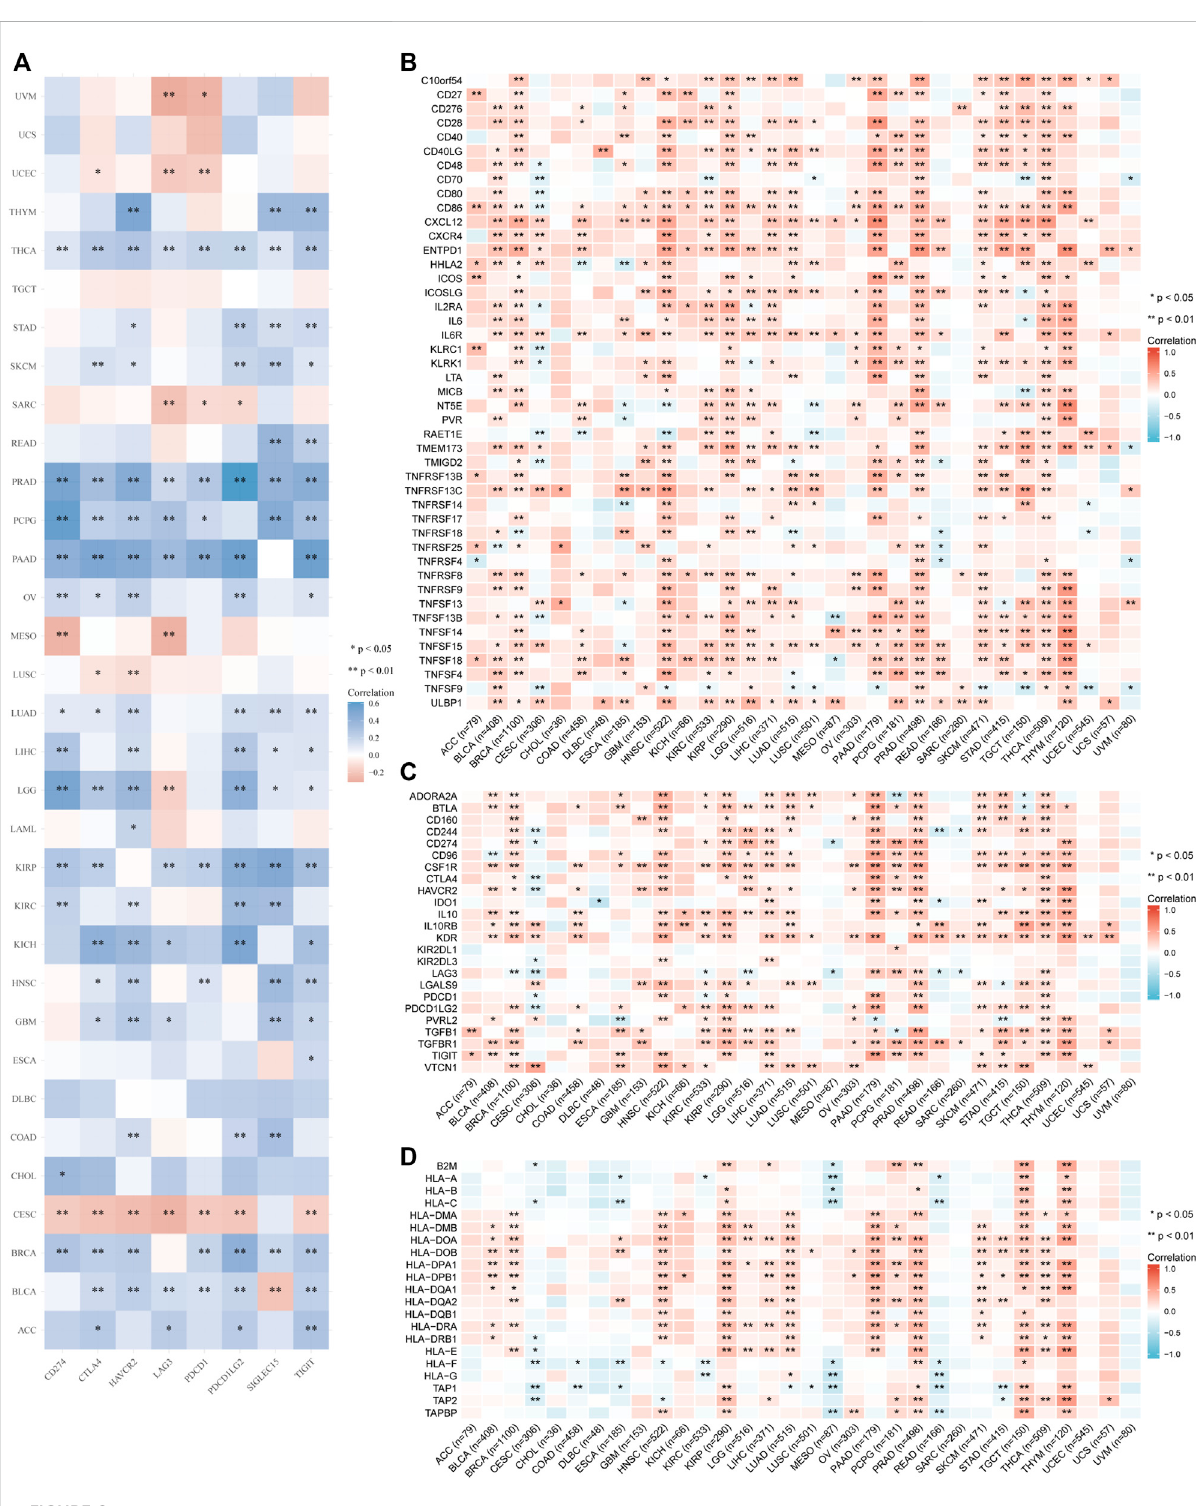
FIGURE 8 Correlation analysis of IGSF10 and immune checkpoints, as well as immune modulators in pan-cancer. (A) The correlations of IGSF10 and common immune checkpoints in pan-cancer. (B) The correlations of IGSF10 and immune stimulators in pan-cancer. (C) The correlations of IGSF10 and immune inhibitors in pan-cancer. (D) The correlations of IGSF10 and MHC molecules in